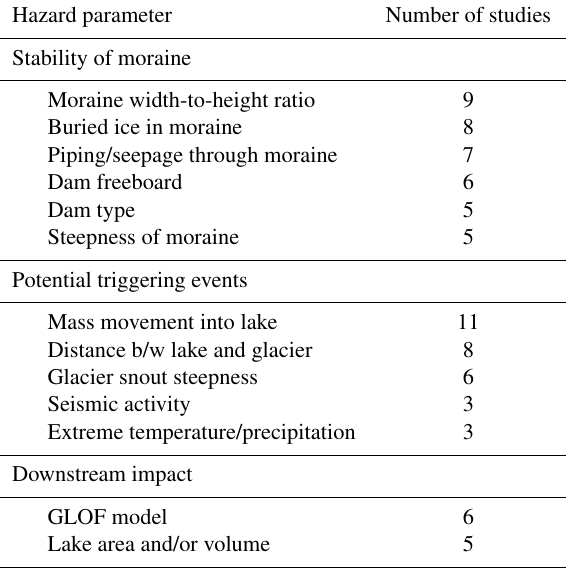
Table 3. Most frequently used parameters associated with previous studies (adapted from Emmer and Vilímek, 2013).